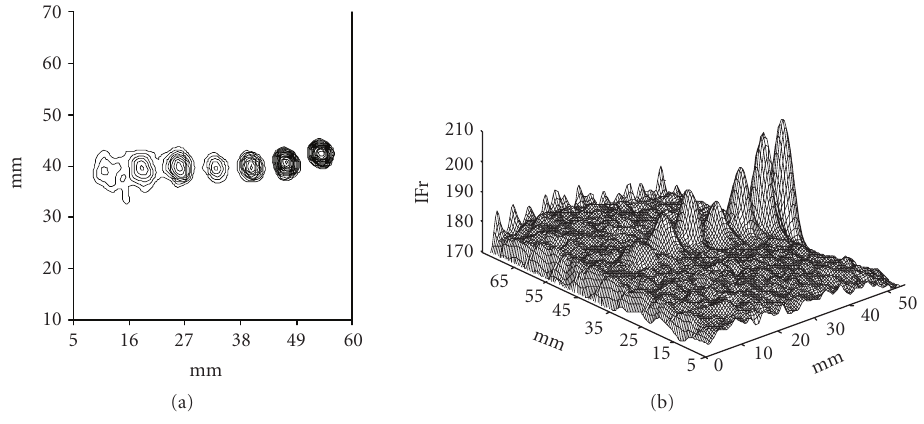
Figure 2: Contour map 2(a) and three-dimensional chromatogram 2(b) scanned at λ exc = 326 nm and λ em = 545nm (slits 10nm) for seven samples of sanguinarine ranged from 5 to 40 ng, after they were eluted with hexane : ethyl acetate : ammonia (25%) (6 : 4 : 0 . 1) (v : v : v) on a silica gel plate.